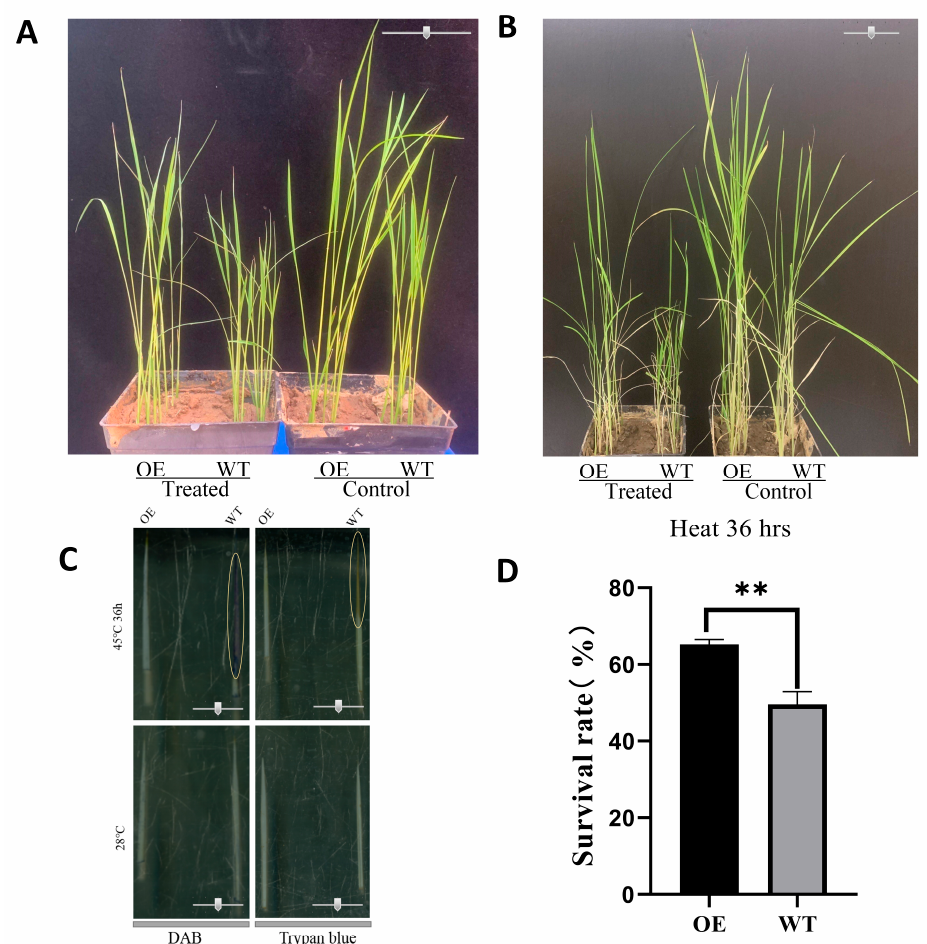
Figure 9. Effect of heat stress on the growth of OsbZIP14 OE and its WT rice seedlings. ( A ) Phenotypes of OE and WT seedlings under heat stress. Seedlings were grown in 28 °C soil for 9 days, then treated at 45 °C for 36 h (scale bars = 5.0cm). ( B ) Rice seedlings under 28 °C normal growth condition after one month of heat stress (Scale bars = 5.0 cm). ( C ) DAB staining of seedling leaf tips before and after heat stress treatment (Scale bar represents 2.0 cm). ( D )The survival rate of the rice seedlings after one month of heat stress. (The statistical significance of the expression changes was determined using the student t-test, with ‘**’ indicating a p -value < 0.01).